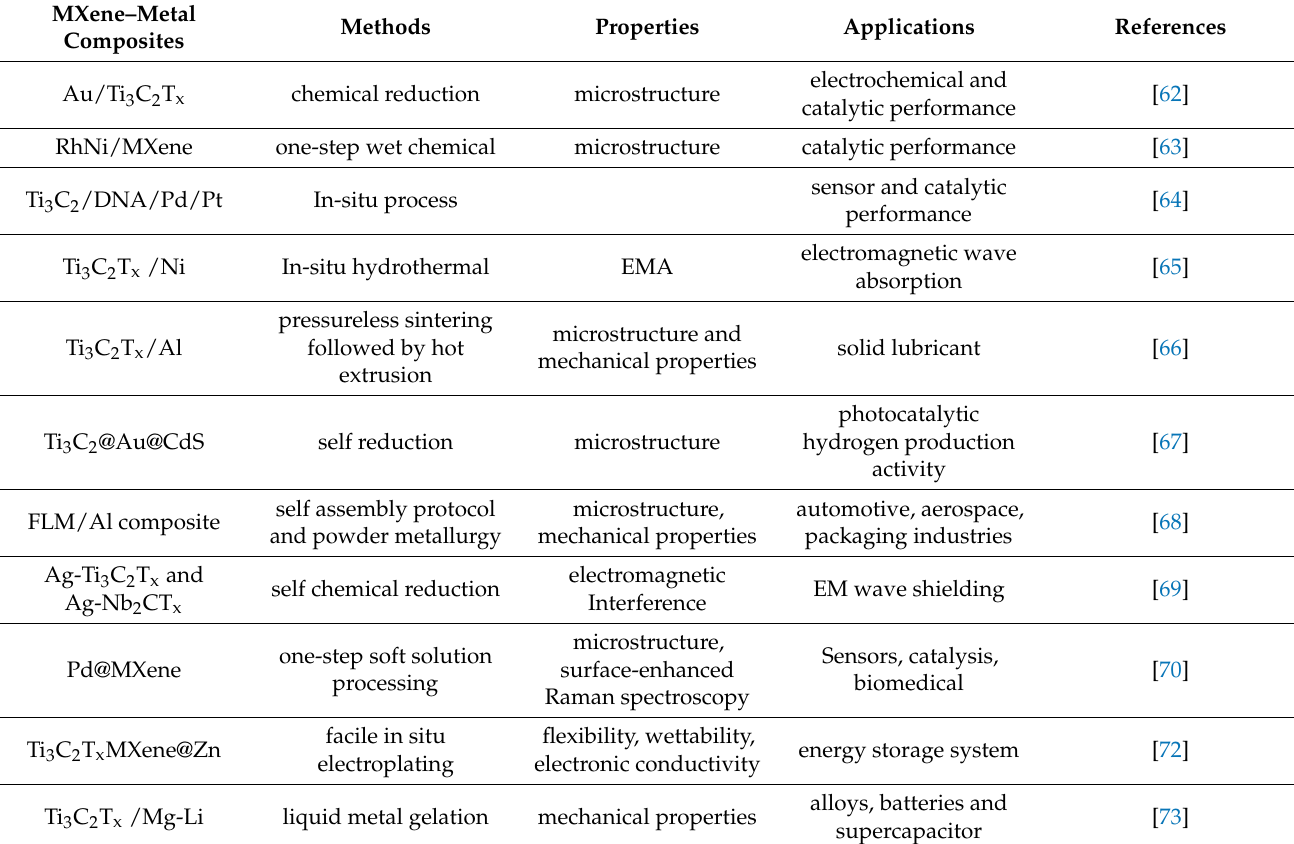
Table 3. MXene–metal composites synthesis, properties and